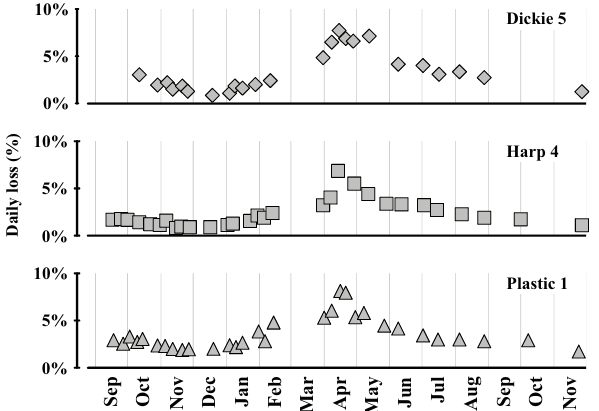
Fig. 5. Potential daily percentage decrease in DOC – calculation is based on the initial DOC concentrations, daily incident solar inso- lation and photodegradation rate constants determined in lab exper- iments (Eq.